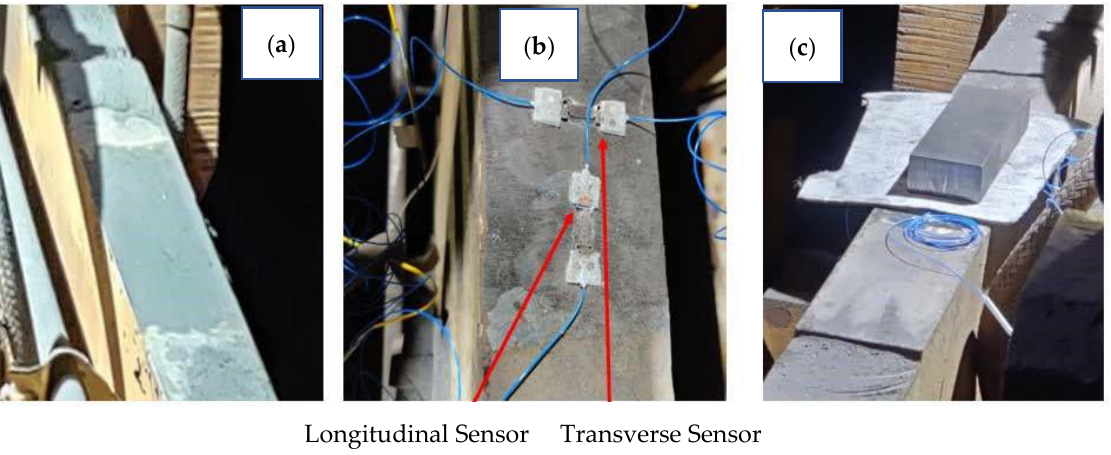
Figure 6. Installation of optical strain gauge sensors: ( a ) beam site preparation, ( b ) sensor placement, ( c ) curing of adhesive under a weight block.